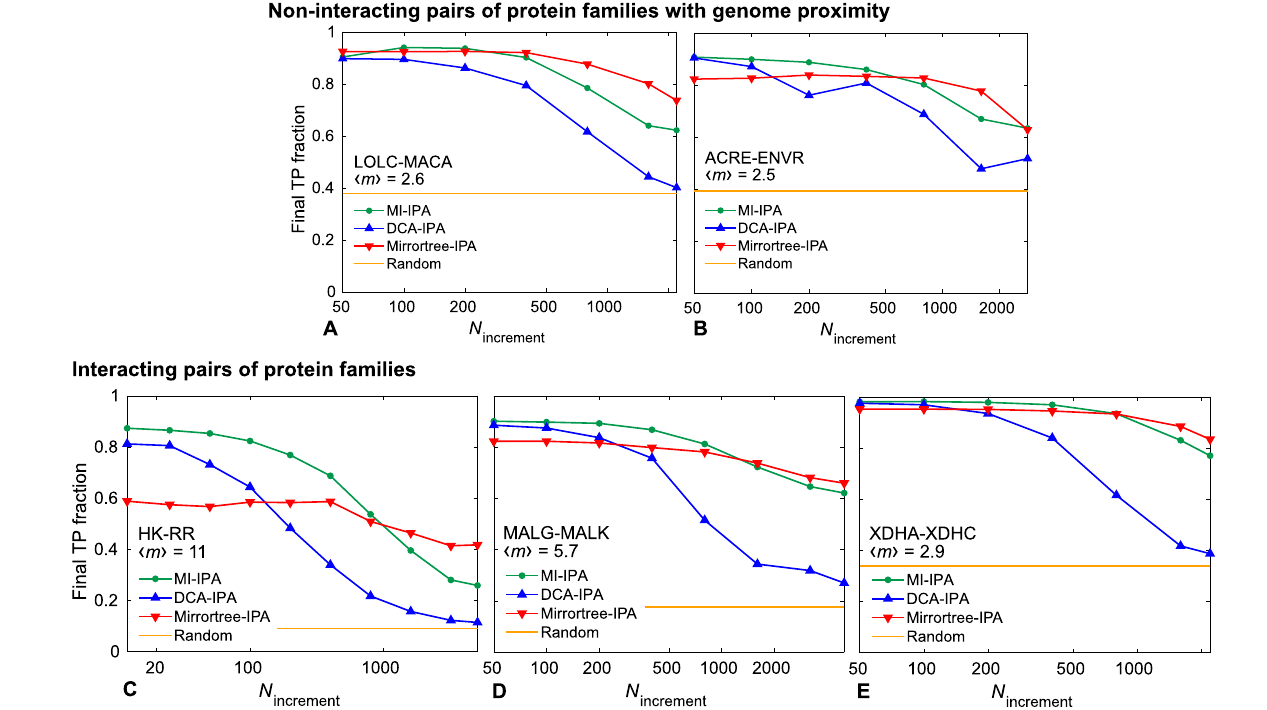
Fig 6. Pairing predictions for real pairs of protein families. The final fraction of protein pairs correctly predicted (TP fraction) obtained without a training set by the MI-IPA, the DCA-IPA and the Mirrortree-IPA is shown versus the increment step N increment of the iterative process. A, B : Pairs of protein families with no known direct physical interaction but that are encoded closely on the genome; datasets include * 2000 homologous pairs. C, D, E : Pairs of protein families with known direct physical interactions; for large families (C and D), datasets of * 5000 pairs comprising only full species were extracted from the larger complete datasets, while in E, the full dataset of * 2000 pairs was used. In all panels, the mean number h m i of pairs per species is indicated, and yellow lines represent the average TP fraction obtained for random within- species pairings. All results are averaged over 50 replicates that differ in their initial random within-species pairings. Datasets were constructed as described in [22, 41], starting from the P2CS database [67, 68] for histidine kinase-response regulator (HK-RR) dataset (C) and using a method adapted from [17] that relies on finding homologs of Escherichia coli protein pairs in all other